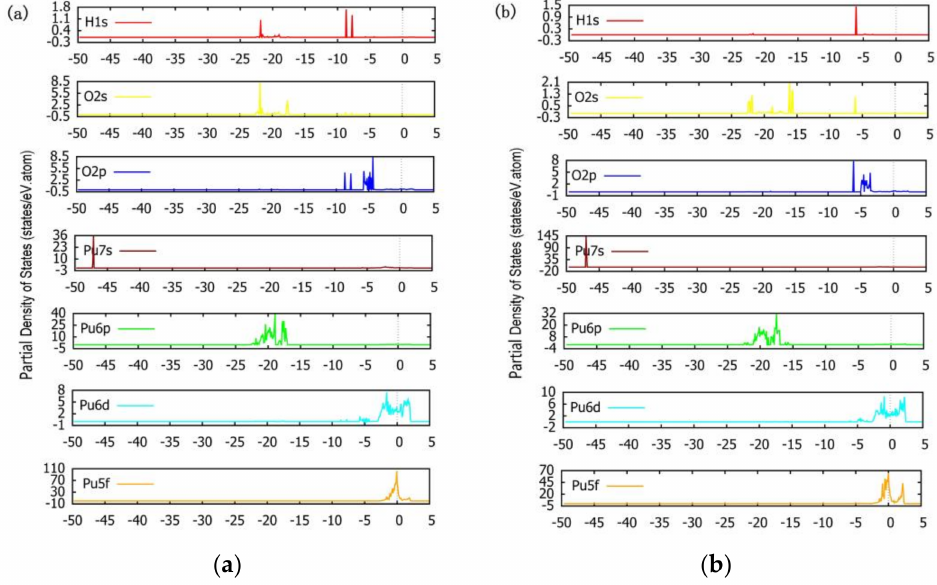
Figure 13. The partial density of states (PDOS) of the two most stable adsorption configurations ( a ): BH-S-H4O10, ( b ): B-S-H2O4. (The dotted line in the figure indicates the location of the Fermi